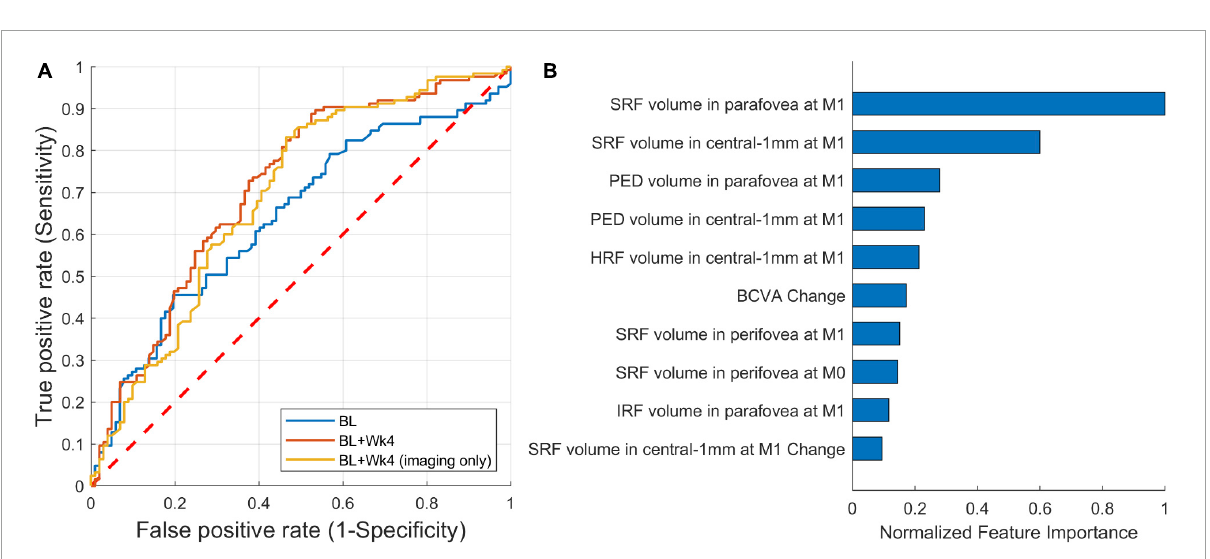
FIGURE6 Performance of predicting extendable patients. (A) Receiver operating characteristic (ROC) of prediction from: baseline (AUC = 0.64), baseline + follow-up (week 4) (AUC = 0.71), and baseline + follow-up restricted to imaging features only (AUC = 0.69). (B) The 10 most important imaging features from the first two visits [baseline (M0) and month one